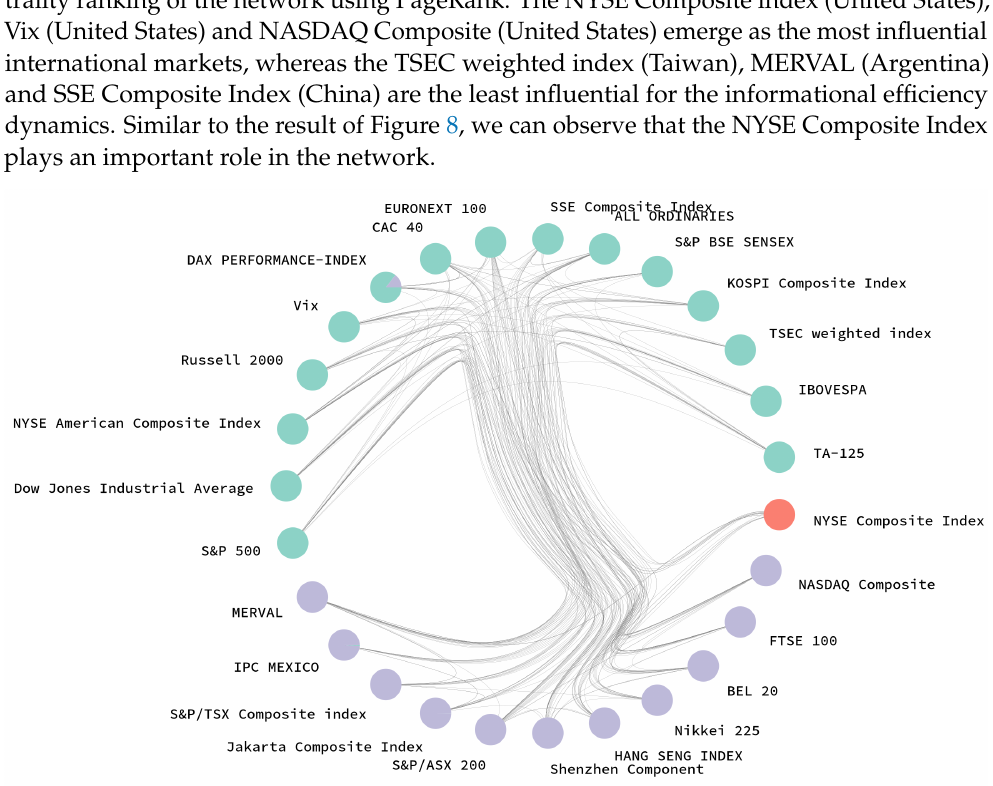
Figure 8. The network structure of international markets exhibiting similar short-tern efficiency trends. By estimating the nested SBM without degree-corrected model, there are two network partitions indicated by the different colors, and edge widths are proportional to the weights of the